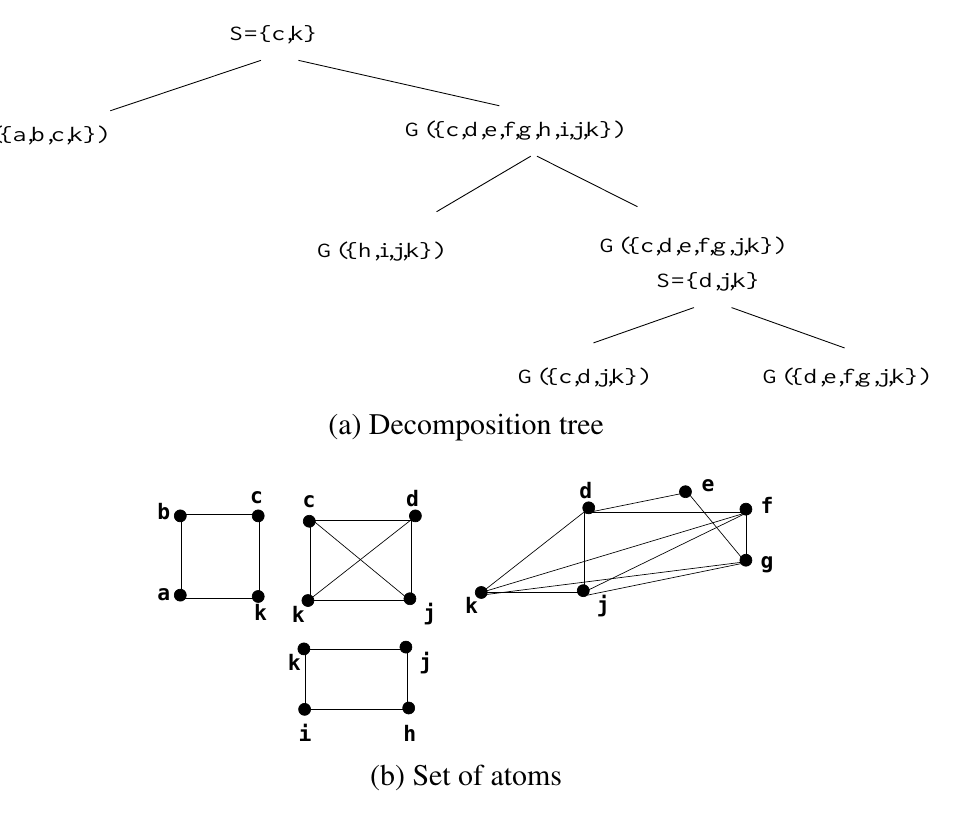
Figure 7. A decomposition tree for graph G from Figure 1 and the set of atoms of G